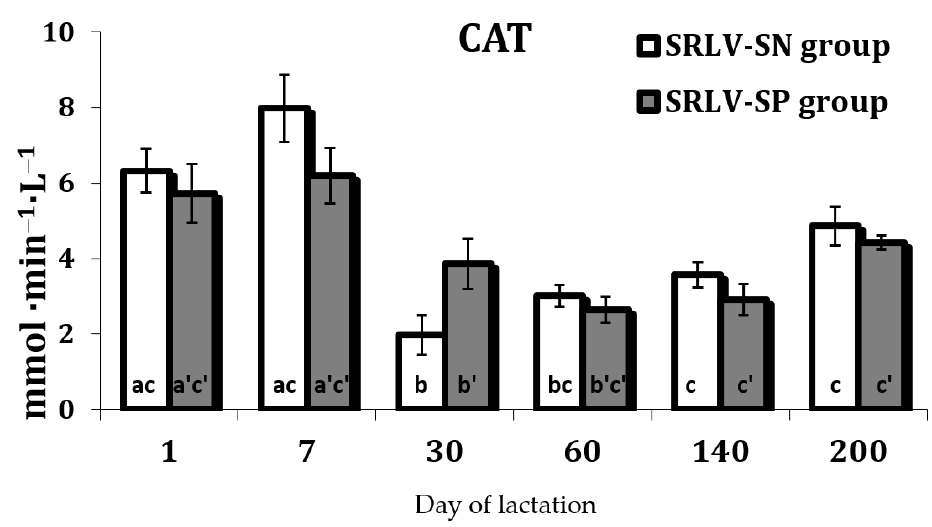
Figure 7. Catalase activity (CAT, mmol H 2 O 2 · min − 1 · L − 1 ) in the serum of SRLV-SN and SRLV-SP goats during lactation. Values are expressed as means ± SEM; a, b, c—different letters indicate significant differences between stages of lactation within the SRLV-SN group at p < 0.05; a’, b’, c’—different letters indicate significant differences between stages of lactation within the SRLV-SP group at p < 0.05; SRLV-SP—small ruminant lentivirus seropositive goats; SRLV-SN—small ruminant lentivirus seronegative goats.